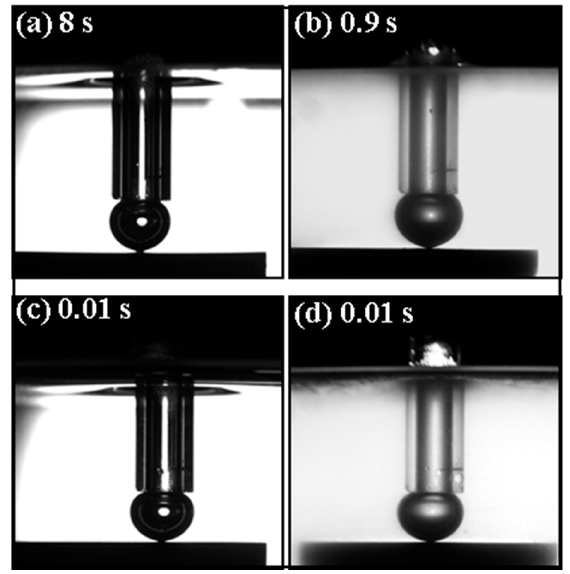
Figure 10. Snapshots of bubble–oxidized coal attachment observed at the minimum contact time in presence of different concentrations of docecane and oleic acid: ( a ) 0.01 mM dodecane; ( b ) 1 mM dodecane; ( c ) 0.01 mM oleic acid; ( d ) 1 mM oleic acid.